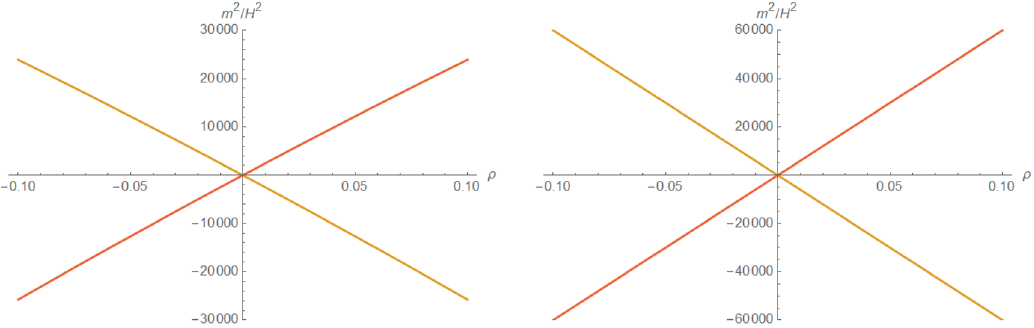
(yellow) and m 2 (orange). We took the parameters as 2 4